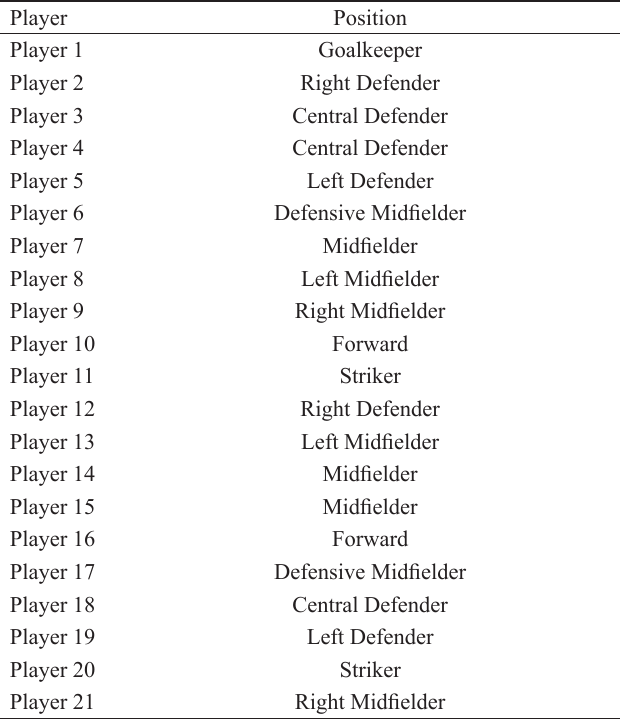
Table 1. Strategic position of each